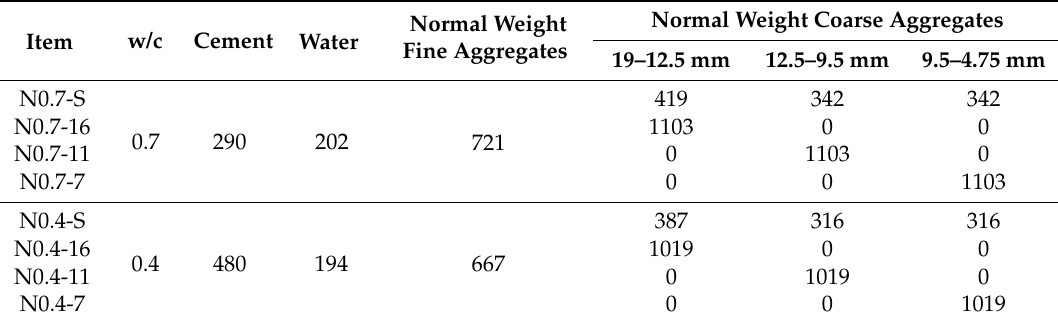
Table 4. Mix proportions of normal-weight concrete (NWC) (kg/m 3 ).